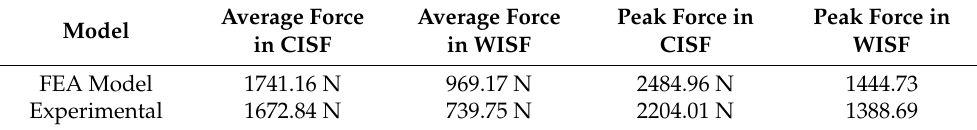
Table 9. Average and peak values of F t obtained from FEA model and experimentally.